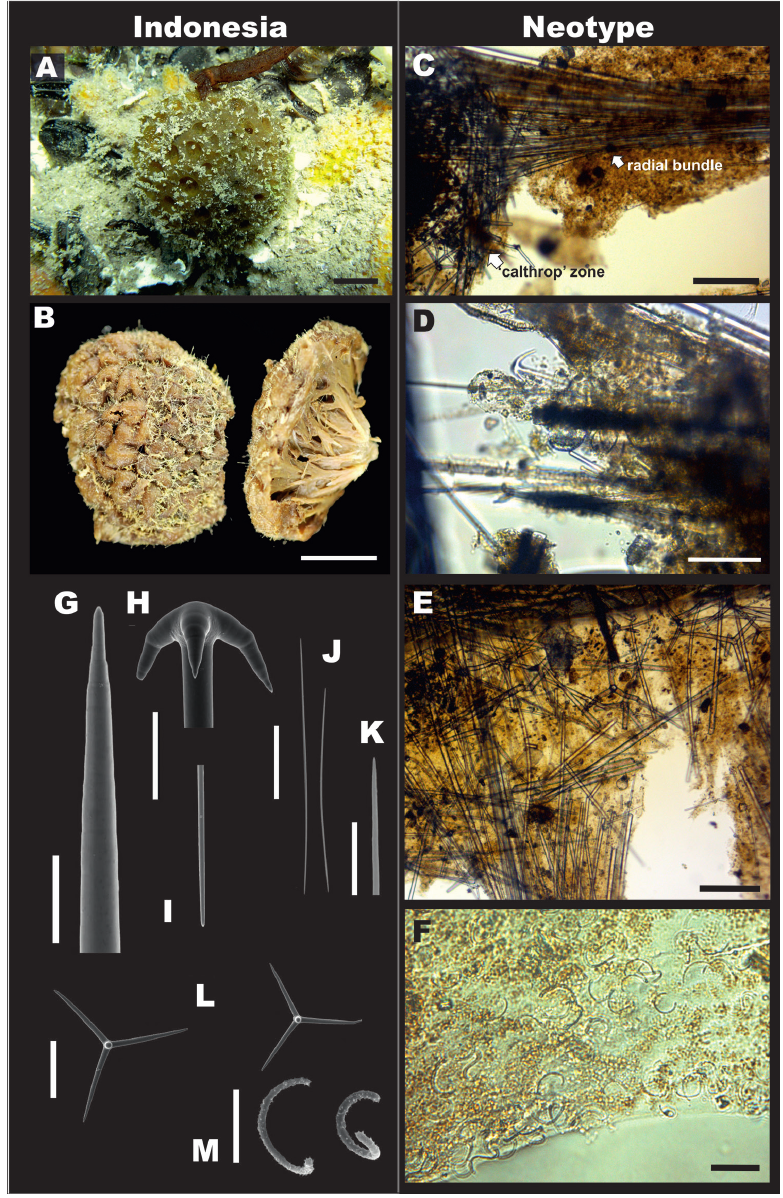
Figure 1. Paratetilla bacca . A,B , G-M RMNH.POR.11292, Kakaban Lake, Indonesia (left side). C–F neotype material of Paratetilla bacca , ZMA.POR.13029, Tutuila Island, American Samoa (right side). A in situ photograph B preserved specimen showing the porocalices (scale bar 1 cm) C skeleton showing oxeas, calthrops and triaenes D skeleton, showing anatriaenes, protriaenes and oxeas E skele- ton showing detail of the ‘calthrop’ zone F sigmaspires G oxea, detail H, I anatriaene, cladus and rhabd end, J thin microxea, K thin microxea, detail L calthrops M sigmaspires. Scale bars: 200 µm ( A–C ); 40 µm ( D, G–I ); 200 µm ( E ); 20 µm ( F ); 50 µm ( J ); 10 µm ( K, M ); 100 µm ( L